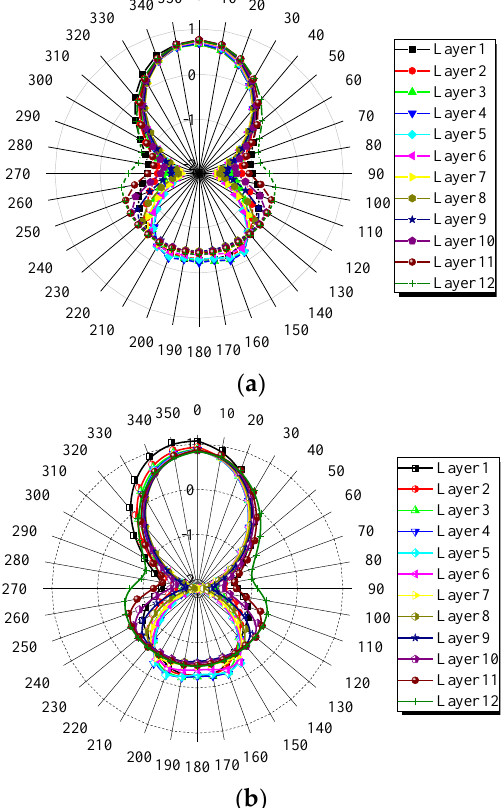
Figure 10. Distribution of average pressure coefficients of the cooling tower under different wind fields. ( a ) Normal wind. ( b ) Typhoon.